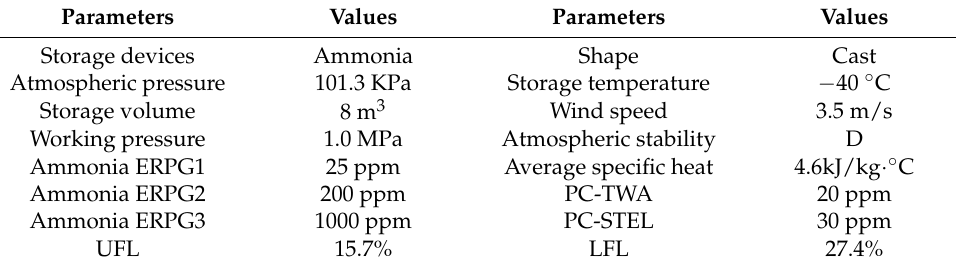
Table 1. Liquid ammonia leakage simulation parameters